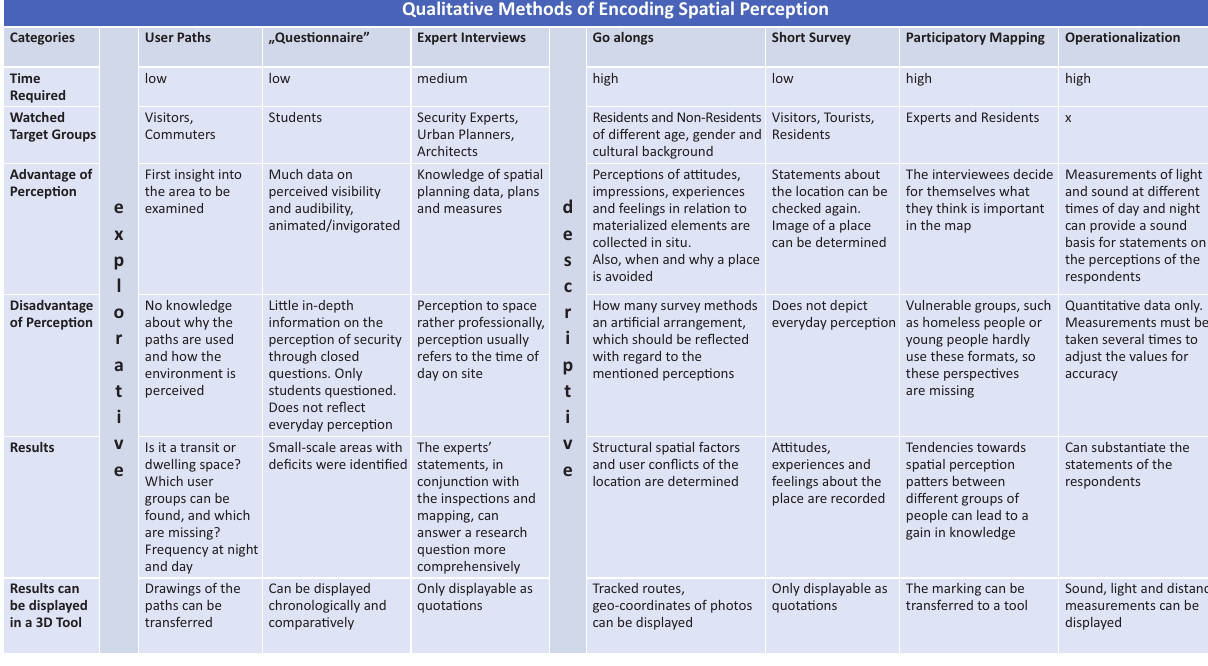
Table 1. Collecting methods for subjective perceptions of security in public